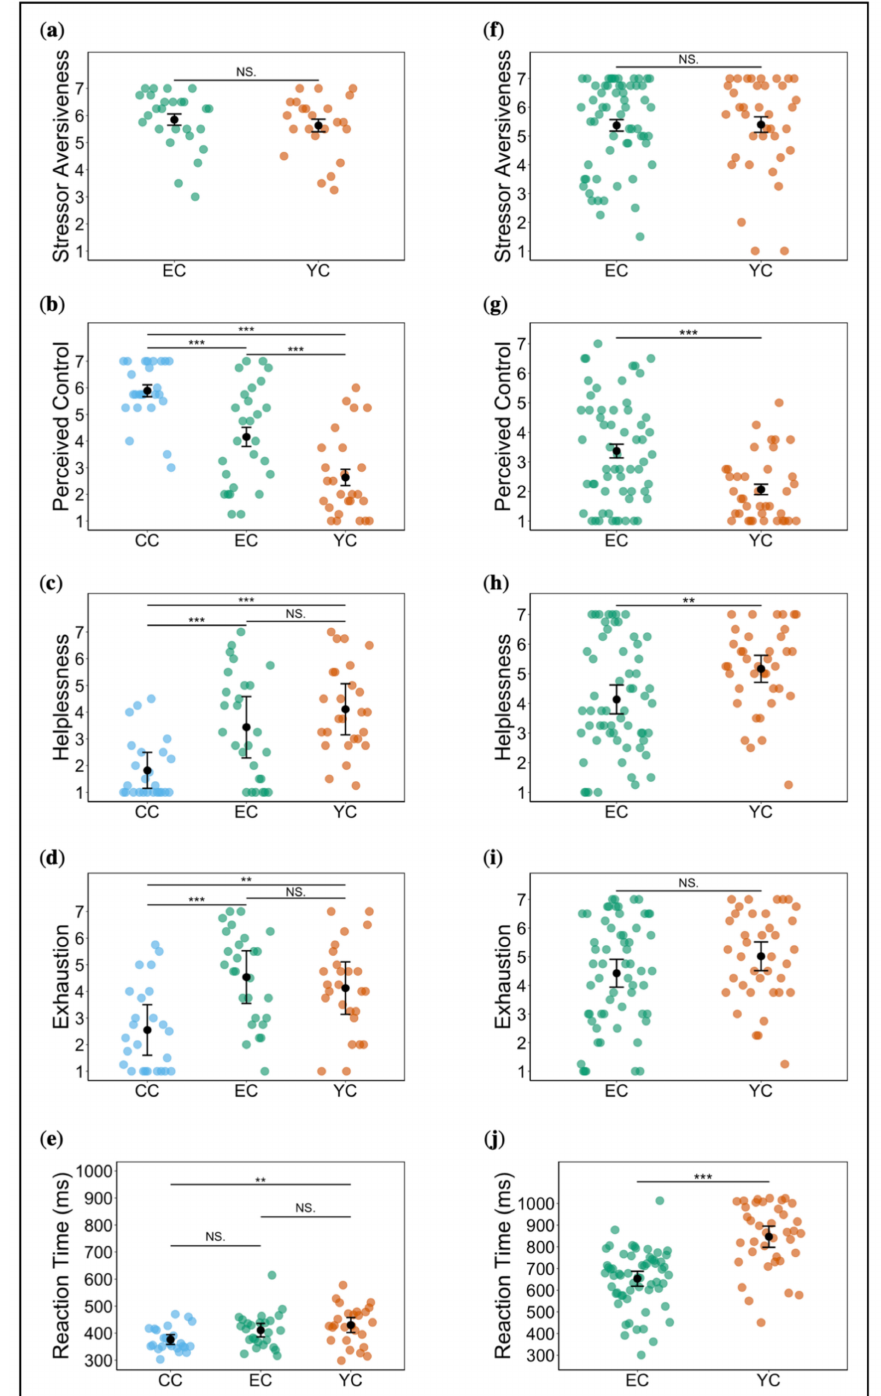
0.01). For analysis of sex di ff erences see Supplement 8.